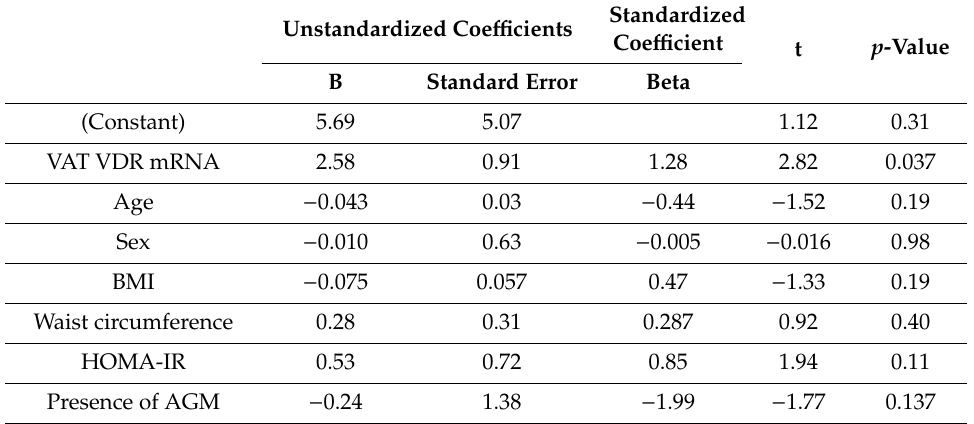
Table 3. Multivariable linear regression analysis. VAT ANGPTL4 expression is the dependent variable. Standardized Unstandardized Coe ffi cients Coe ffi cient t p -Value B Standard